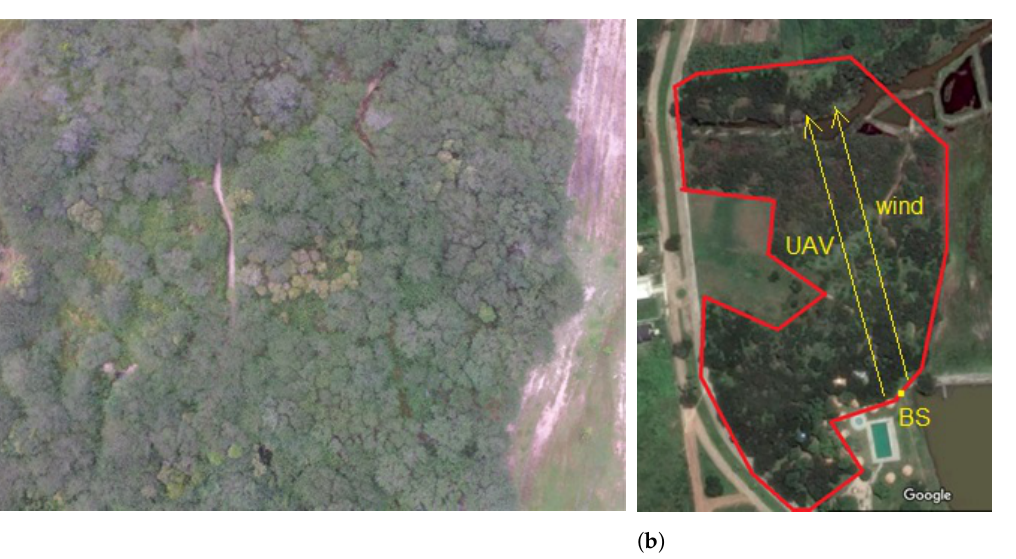
Figure 4. Caatinga biome region. ( a ) Flight region over the Caatinga vegetation. ( b ) Area of the flight over the Caatinga vegetation.